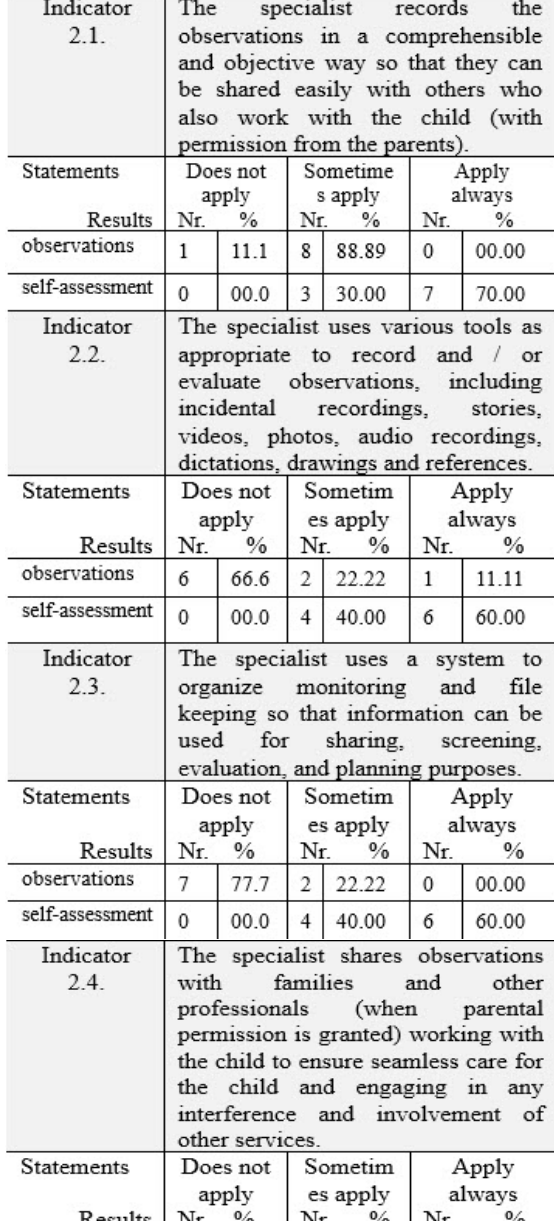
Table 23. Principle 2: Monitoring is most useful when documenting, analyzing and sharing with parents / families and other people involved in the care and well-being of the